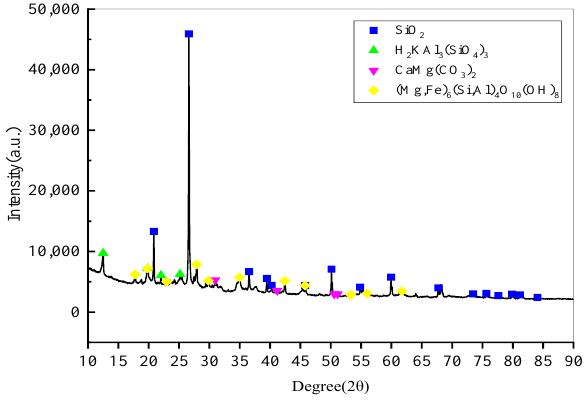
Figure 4. XRD spectrum of a soil specimen.